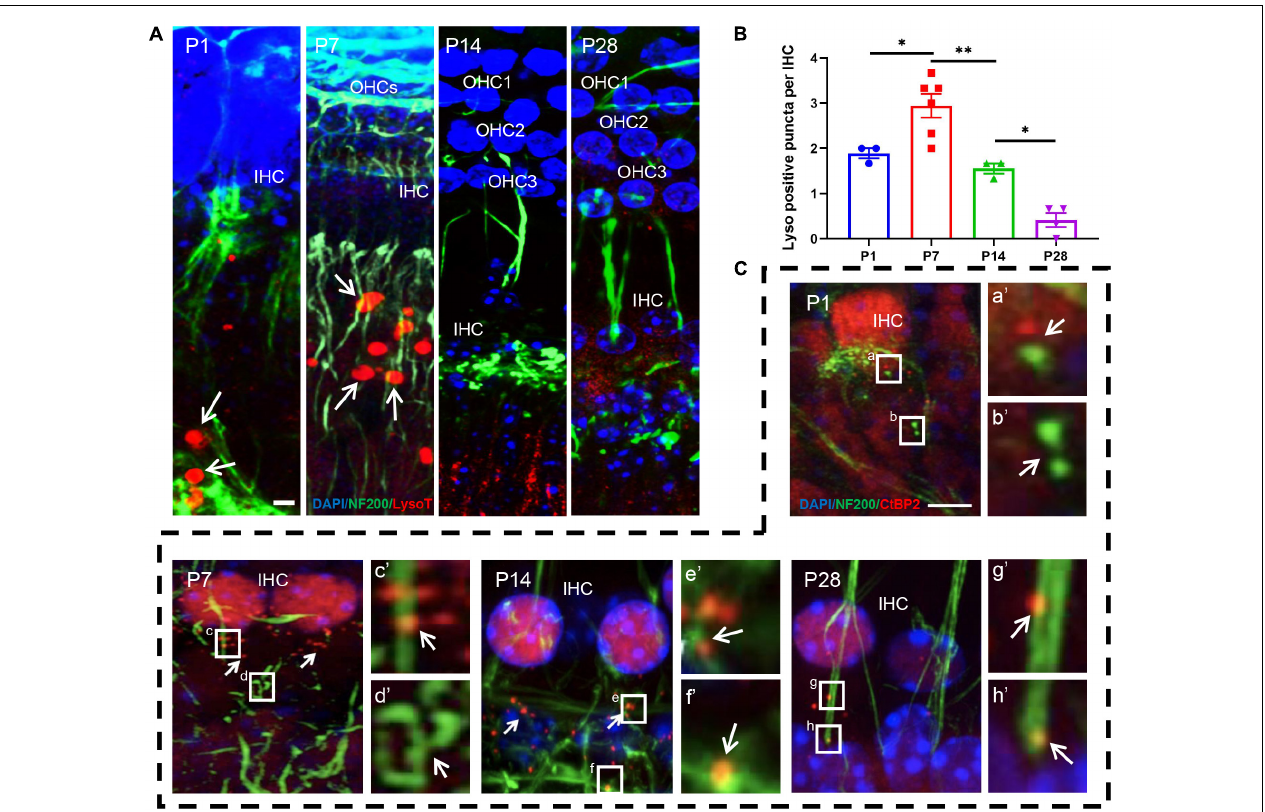
FIGURE 6 | LysoTracker Red detection and examination of co-localization between ribbon synapses and auditory nerve fibers. (A) The signals of LysoTracker Red (red signals in round shape) were clearly observed at P1 and P7 (white arrows indicated); auditory nerve fibers were identified using anti-NF200 (green, corded). Signals for LysoTracker Red almost disappeared at P14 and P28. Scale bar = 5 µ m. (B) Quantitative analysis of LysoTracker Red signals. The largest number of signals was found at P7, and a significant loss of LysoTracker Red signals was observed at P14 and P28 (* p < 0.05; ** p < 0.01). (C) Poor co-localization between CtBP2-positive puncta and NF200-stained spots at P1: white frames (a,b) and enlarged images [ (a (cid:48) ,b (cid:48) ) white arrows indicated] with the red and green signals clearly separated. A significantly improved co-localization level between red and green signals can be found at P7, P14 and P28; see c and d (P7), e and f (P14), g and h (P28), as well as their enlarged images [ (c (cid:48) –h (cid:48) ) respectively]. NF200, neurofilament